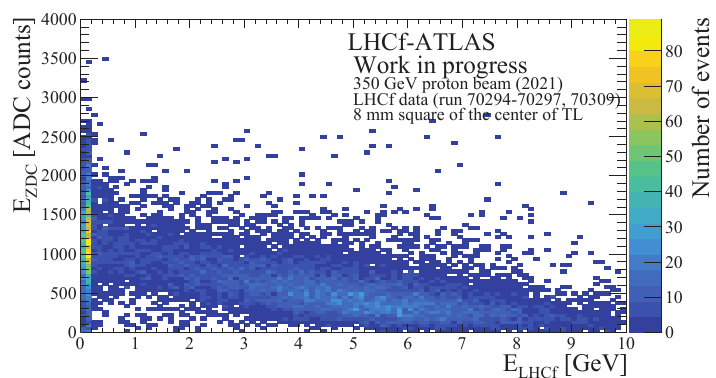
Figure 2. Correlation of the energy deposit in LHCf and the ZDC. The horizontal axis shows the total of LHCf energy deposit [GeV]. The vertical axis shows the summation of three ZDC modules’ ADC counts.